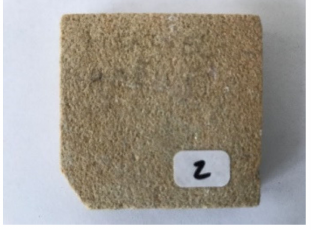
Figure 4. Hoˇrice sandstone sample image.